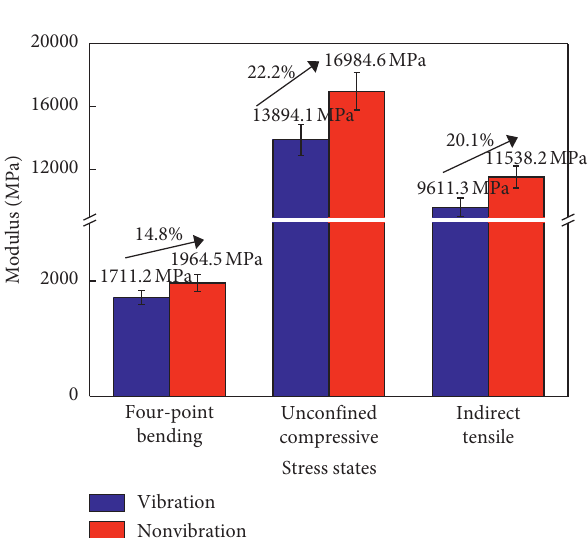
Figure 7: Standard modulus of vibratory and nonvibratory mixed specimens under different stress states.